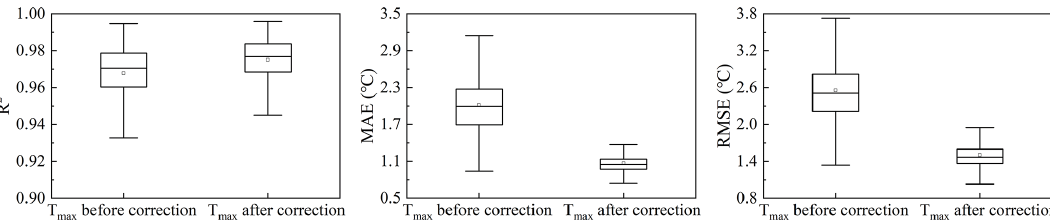
Figure 6. Box plots of the R 2 , MAE and RMSE of comparison between T max before correction and T max after correction in the whole China region.